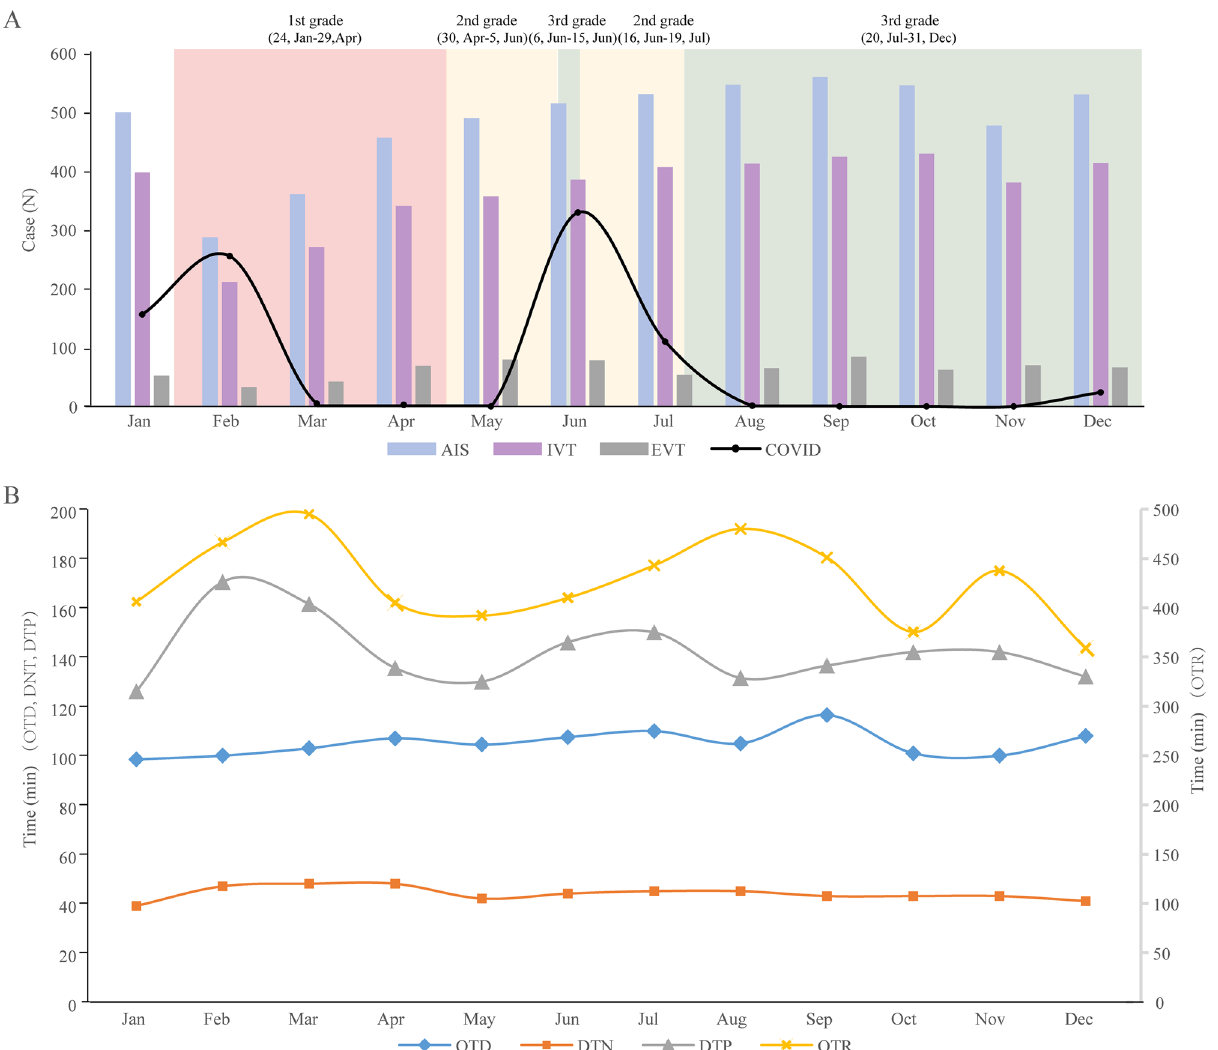
Figure 3. Monthly Quality Metrics for AIS in 2020. ( A ) Monthly volume of strokes across Beijing Stroke Quality Control Centre and COVID-19 cases in Beijing in 2020. ( B ) Mean timings of stroke activations